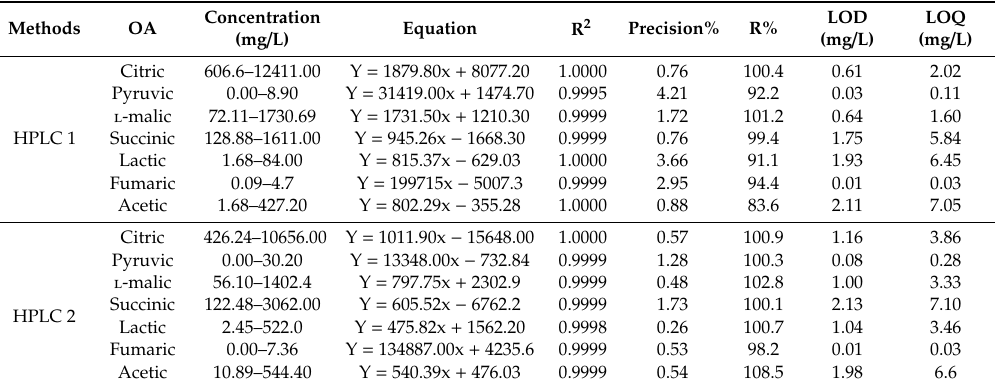
Table 3. Validation parameters for the two HPLC